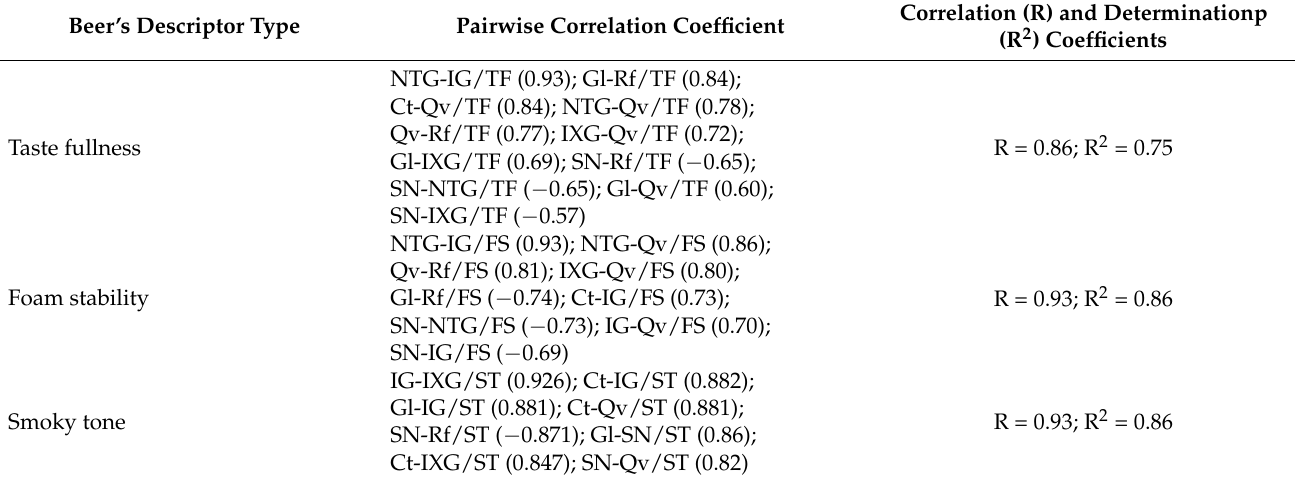
Table 13. Correlation characteristics of different organic compounds of beer samples (reliability limit p <